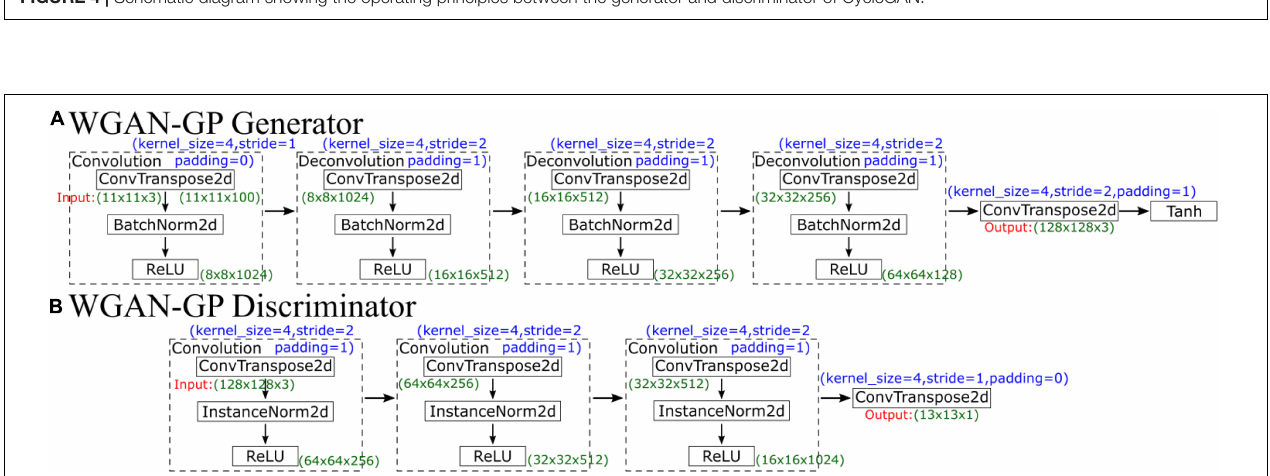
Frontiers in Plant Science |